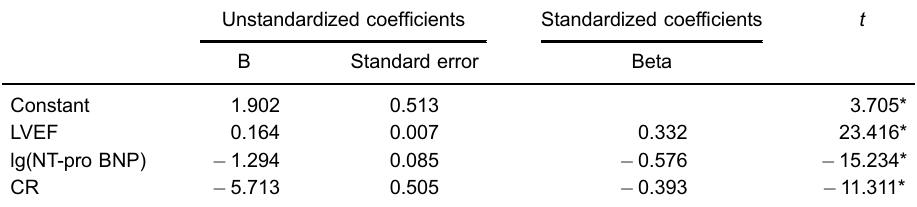
Table 6. Results of multiple linear regression